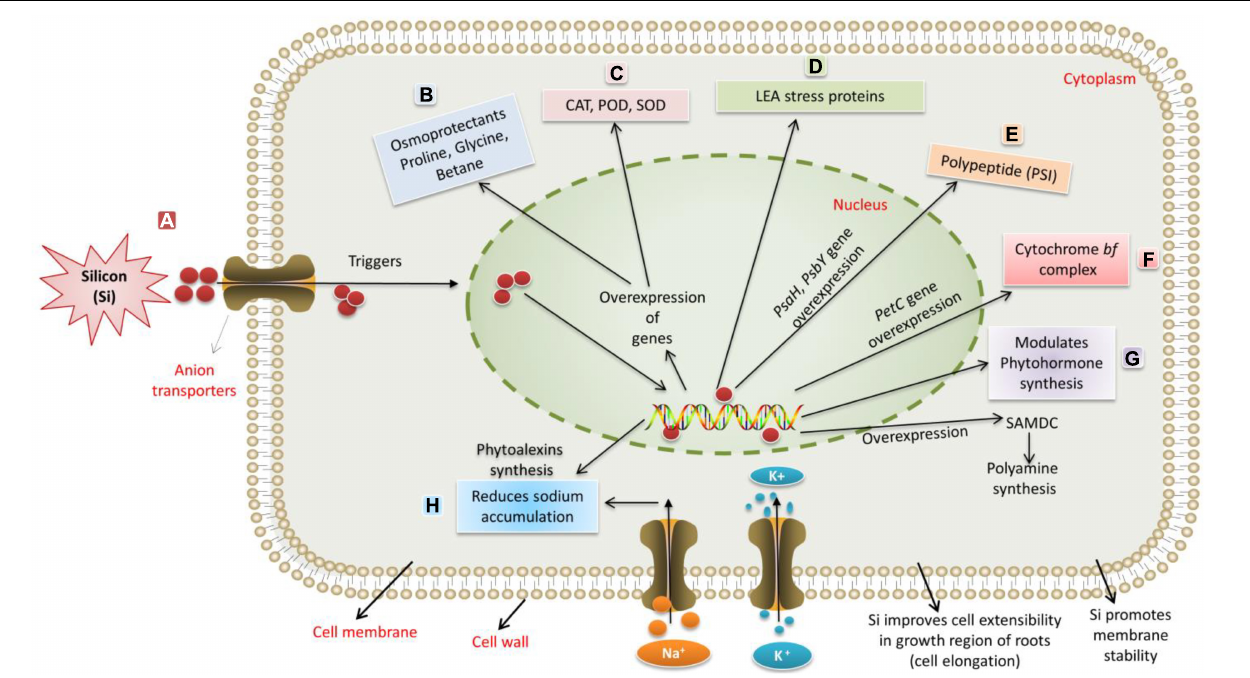
FIGURE 2 | The silicon-induced mechanism for regulating abiotic stresses. (A) Silicon is taken up through anion transporters. (B) Drought and salinity stress induce osmotic stress and osmotic imbalance. Si enhances the synthesis of osmoprotectants like proline, glycine, and betaine. (C) Stress induces the formation of ROS. Si enhances the expression of CAT, SOD, and POD for protection against oxidative damage. (D–F) Si supplementation results in transcriptional regulation of genes related to photosynthesis, such as overexpression of PsaH, which encodes essential polypeptide subunits of photosystem-I (PSI) dimer, the PsbY ( Os08g02530 ) gene encoding polyprotein component of Photosystem II and the PetC gene, encoding Rieske Fe-S center-binding polypeptide of cytochrome bf complex. (G) Si modulates the synthesis of plant growth regulators to alleviate stress. Si induces the S-adenosyl-L-methionine decarboxylase (SAMDC) gene, encoding essential enzymes responsible for synthesizing polyamines. (H) Salinity stress negatively affects plant growth by increasing the accumulation of ions up to toxic levels. Due to a higher influx of NaCl, plants experience more severe oxidative and ionic stress. Sodium-ion accumulation up to toxic levels triggers ROS production, which, in turn, severely damages the cellular components and accelerates senescence in mature leaves, leading to reduced growth and metabolism. Si administration improves uptake of K + , which, in turn, stimulates H+-ATPase enzymes in the plasma membrane that helps to overcome salt stress.